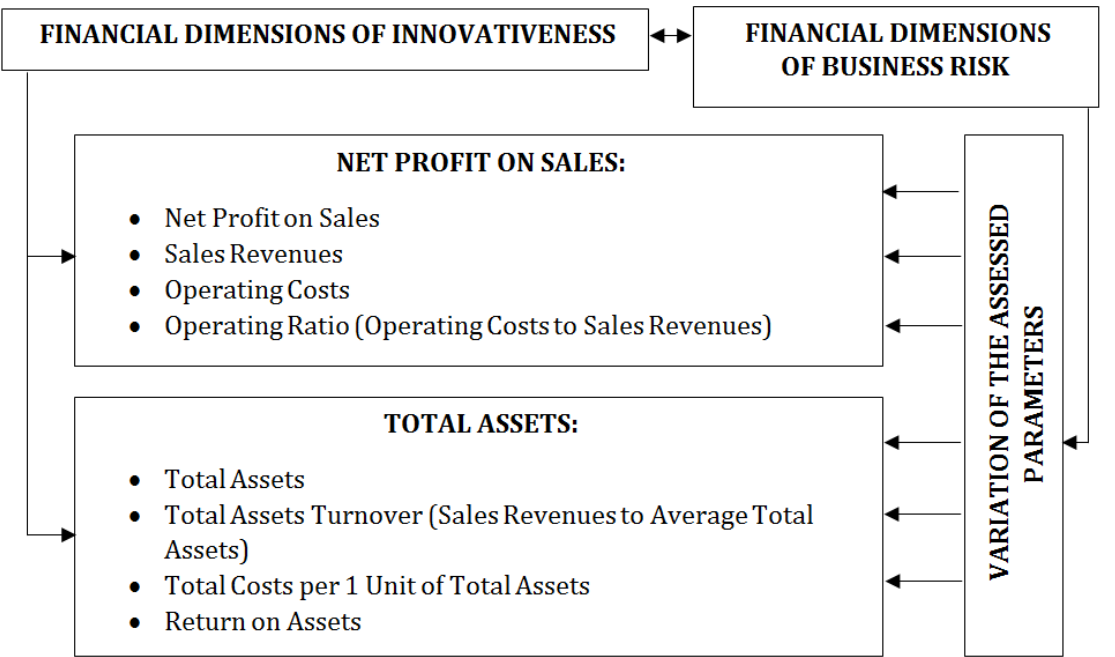
Figure 1. Business risk assessment model in the context of corporate innovativeness. Source: own work.